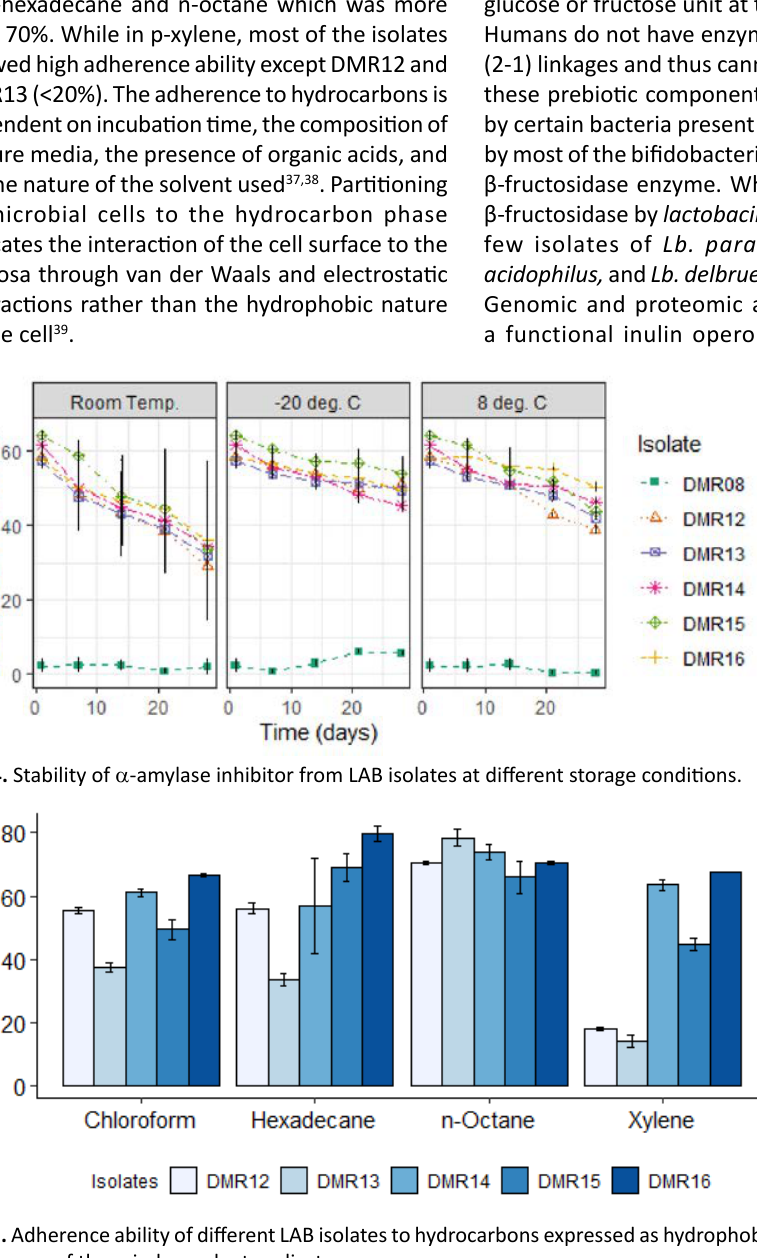
Fig. 5. Adherence ability of different LAB isolates to hydrocarbons expressed as hydrophobicity (%). Data represent the means of three independent